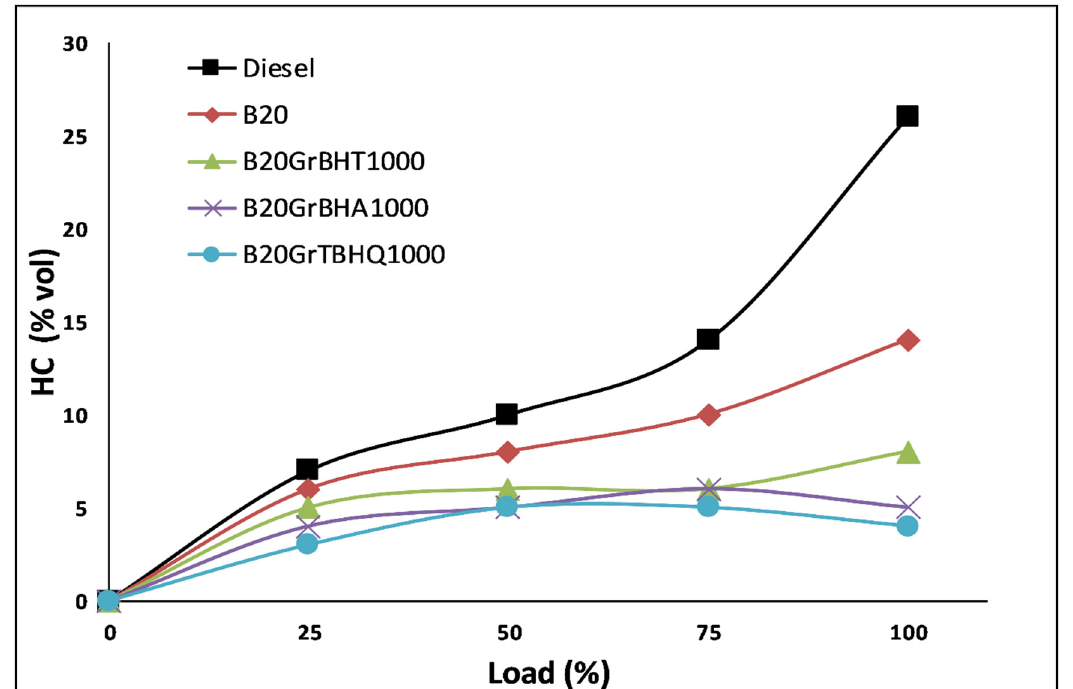
Figure 10. Deviation of hydrocarbon emission with loading.